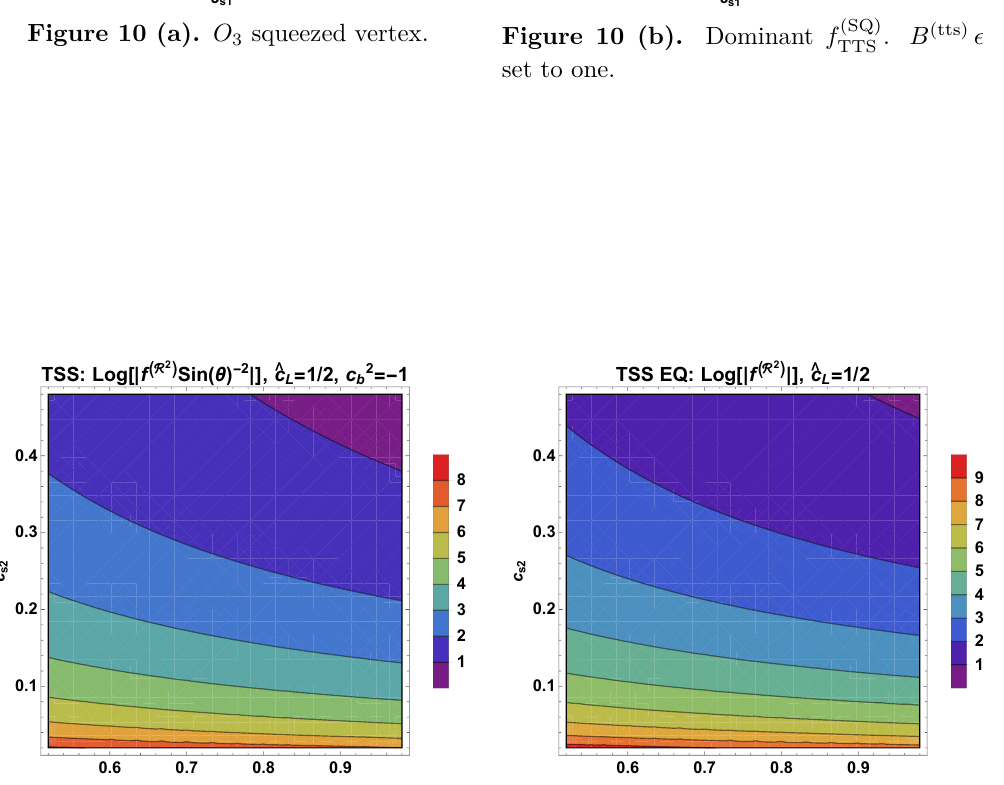
in the c 2 = − 1 case. On the left the squeezed f 0 b